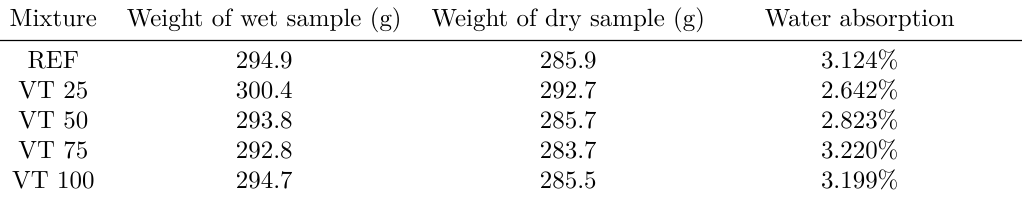
Table 2. Water absorption of tested high-performance concrete samples.